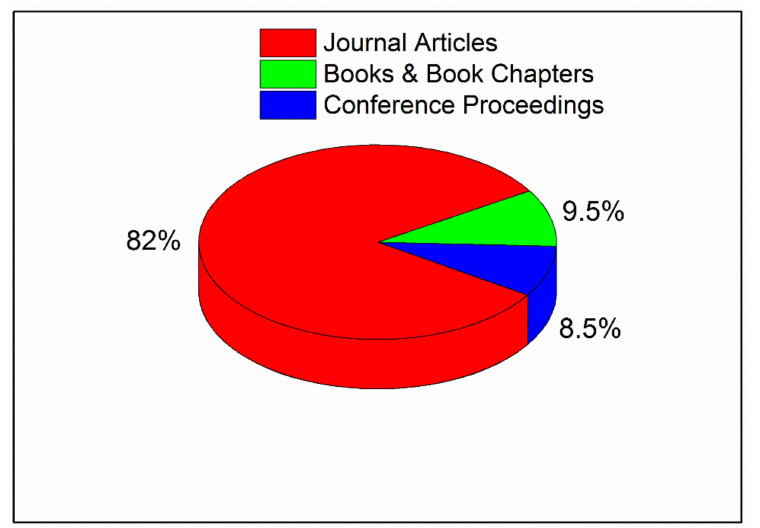
Figure 3. Type of publication